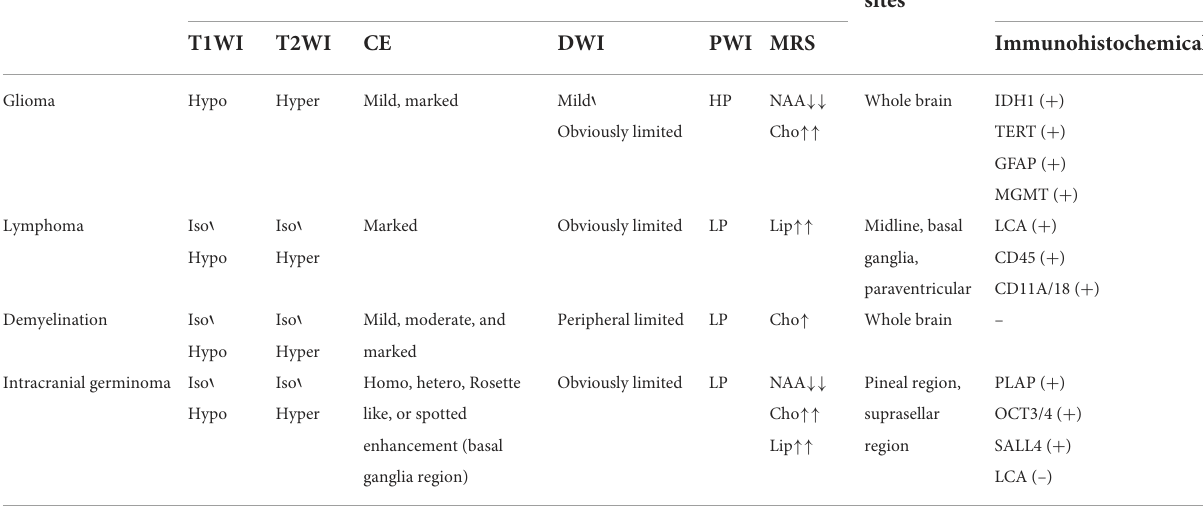
TABLE 3 Common differential diagnosis as follow.